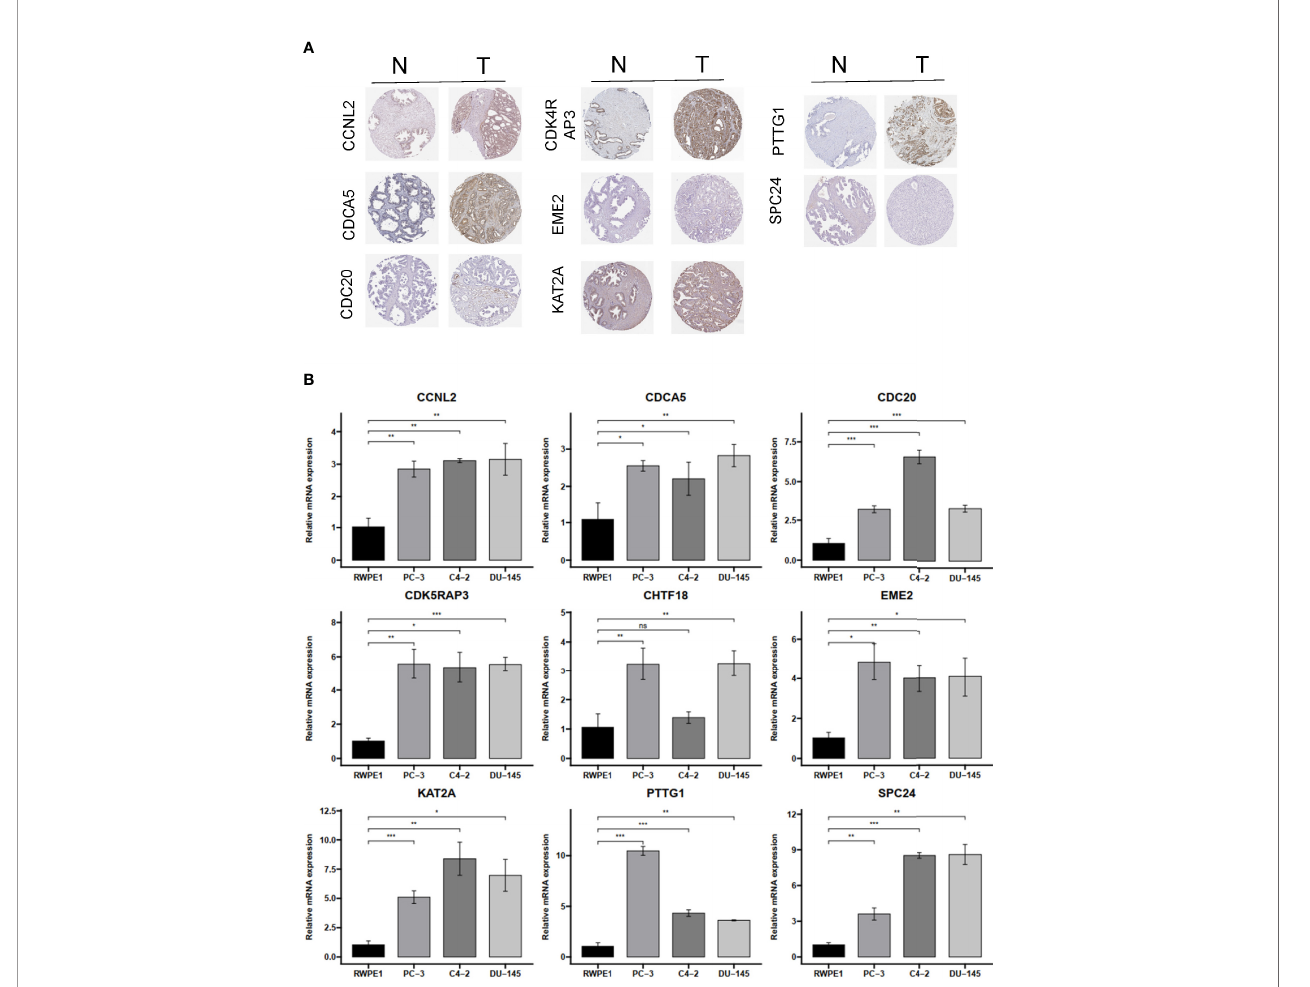
FIGURE 9 | The IHC expression pattern based on HPA dataset and mRNA levels by qRT-PCR of CCNL2, CDCA5, CDC20, CDK4RAP3, EME2, KAT2A, PTTG1, REC8, and SPC24. (A) The IHC results of nine hub genes in prostate cancer and normal tissues based on HPA. (B) The mRNA level of nine hub genes in normal prostatic epithelial cell (RWPE-1) and prostate cancer cell lines. IHC, immunohistochemistry; HPA, Human Protein Atlas. ns, no signi fi cance. * p < 0.05, ** p < 0.01, *** p <